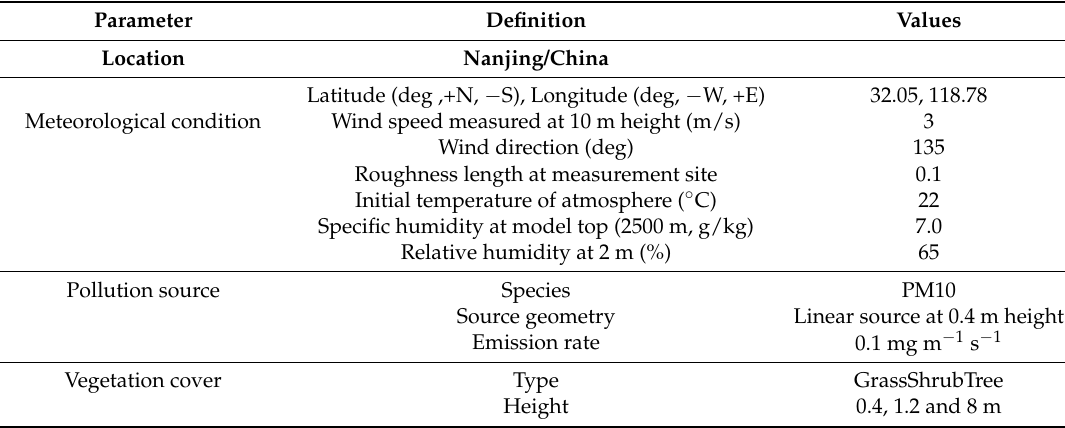
Table 3. Initial and boundary conditions used in ENVI-met